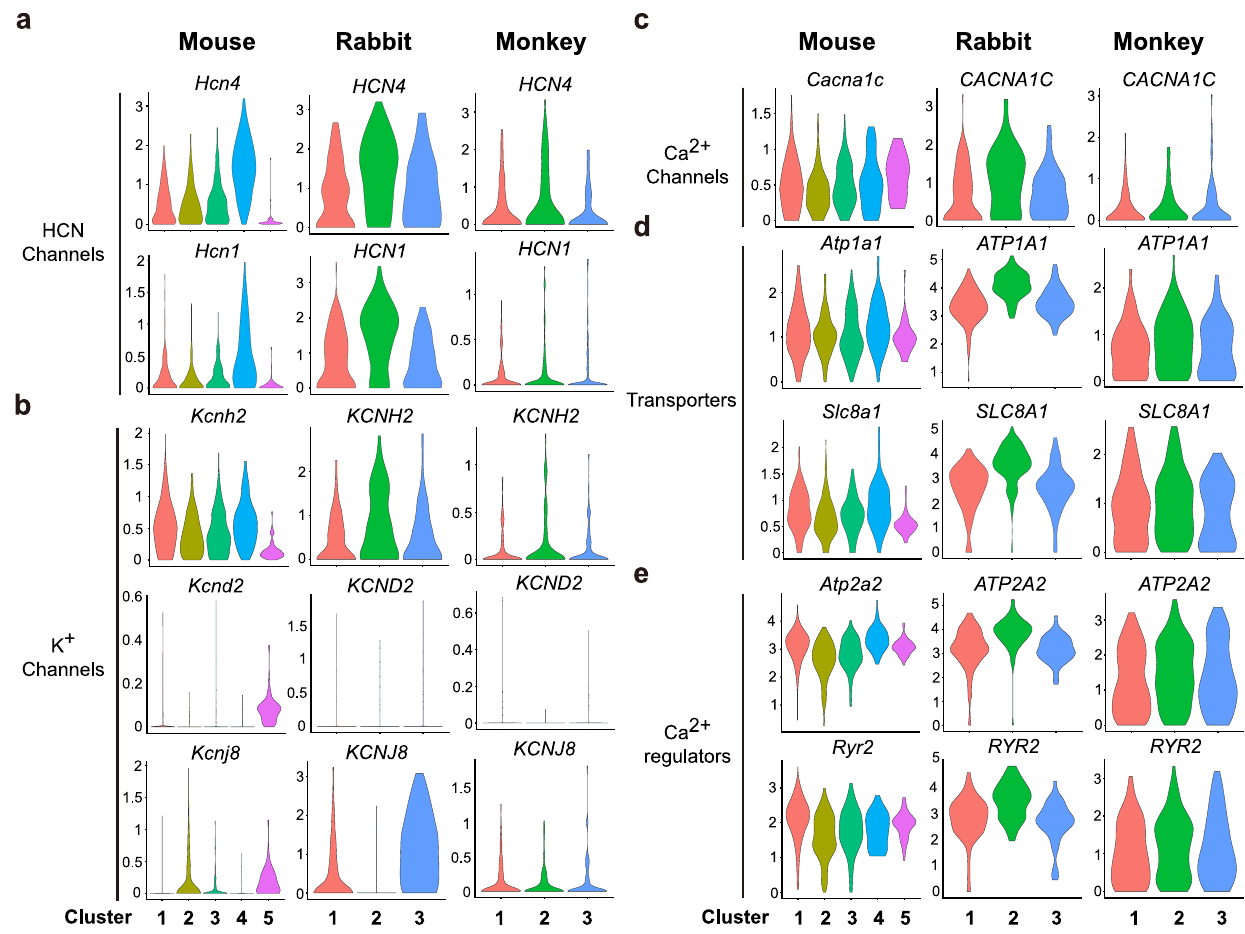
Fig. 8 Relative expression of key functional gene related to autonomic rhythm of sinoatrial node (SAN) cells among three species. a Expression of HCN channel genes. b Expression of K + channel genes. Kcnd2 was detected in atrial and ventricular (AV) cells but low expression in SAN cells. c Expression of Ca 2 + channel genes. d , e Expression of transporter and Ca 2 + regulator